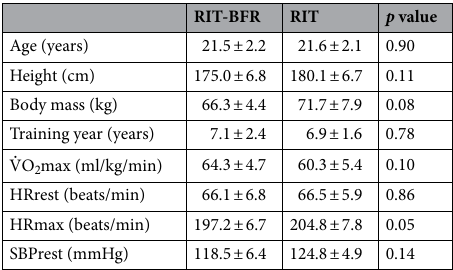
Table 1. Subject